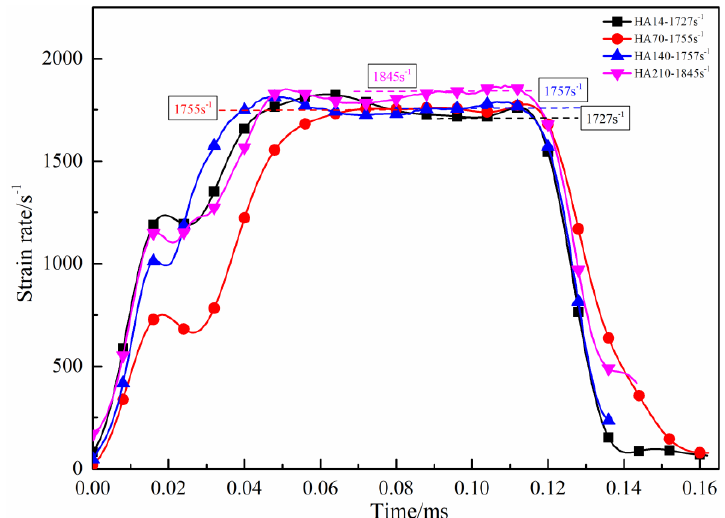
Figure 8. The strain rate history curves under dynamic loading for specimens after 14, 70, 140, 210 hygrothermal aging days under typical strain rate 1700 – 1800 s −1 .